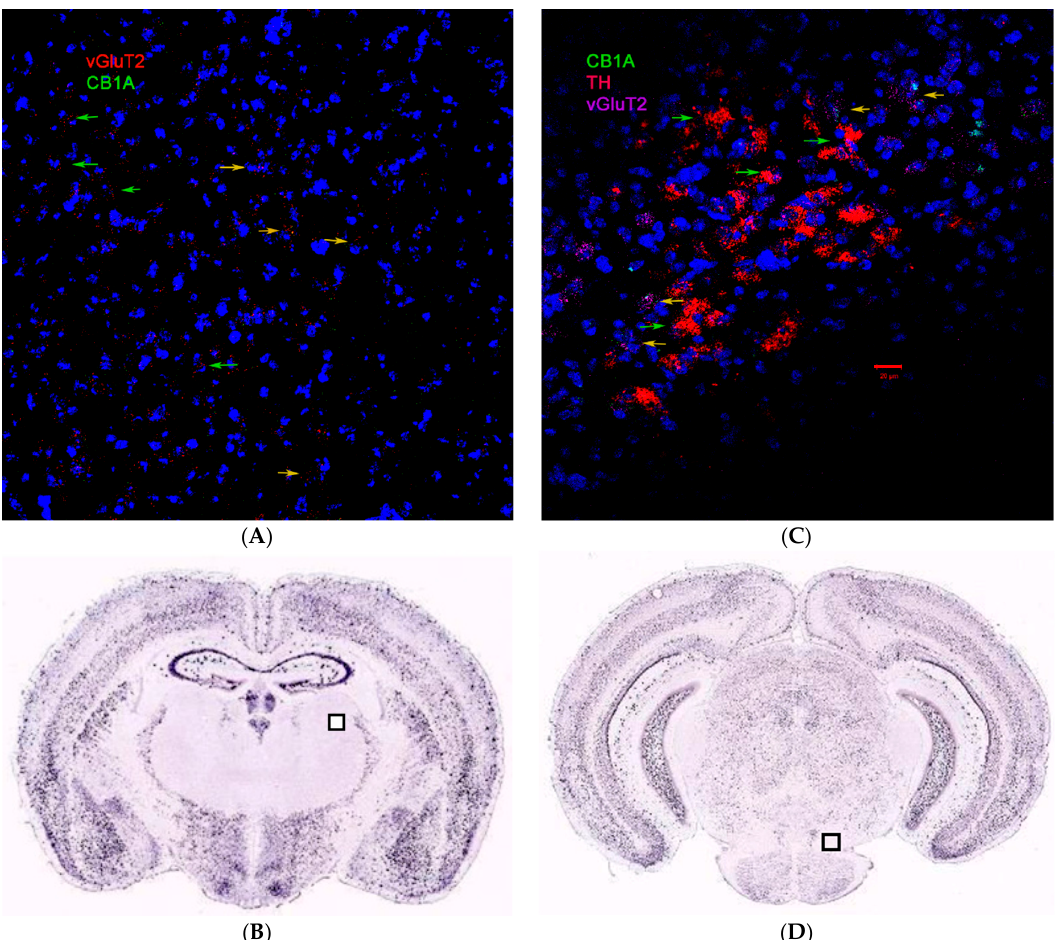
Figure 3. RNAscope in situ hybridization (ISH) for CB1A ( A ) brain anatomical expression in glutamatergic neurons of thalamus. Yellow arrows represent CB1A and vGluT2 co-expression in medium thalamic nucleus and green arrows represent the absence of CB1A in vGluT2 neurons. ( B ) Corresponding Allen Brain Atlas conventional CB1R ISH in mouse lateral thalamus (box). RNAscope ISH for CB1A ( C ) brain anatomical expression in dopaminergic and glutamatergic neurons of lateral VTA. Yellow arrows represent CB1A, and vGluT2 co-expression and green arrows represent the absence of CB1A in dopaminergic neurons. ( D ) Corresponding Allen Brain Atlas conventional CB1R ISH in mouse VTA (box). Scale bar is 20 µ m.